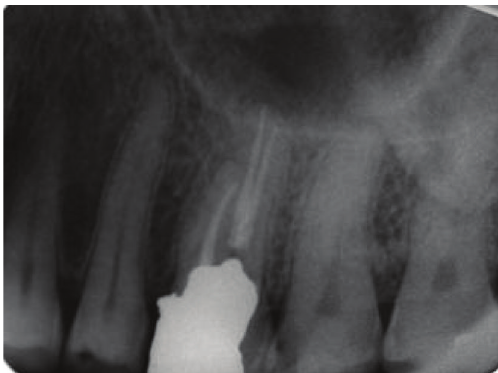
Figure 6: 12 months follow